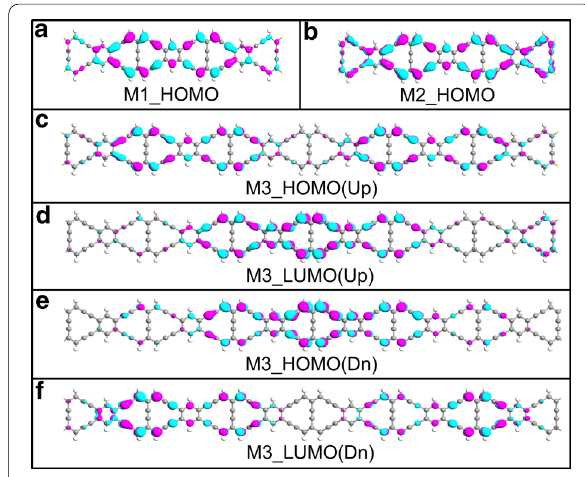
Fig. 7 (Color online) The HOMOs for a M1 and b M2 in spin-up direction; c – f The spatial distribution of HOMOs and the LUMOs for M3 in different spin